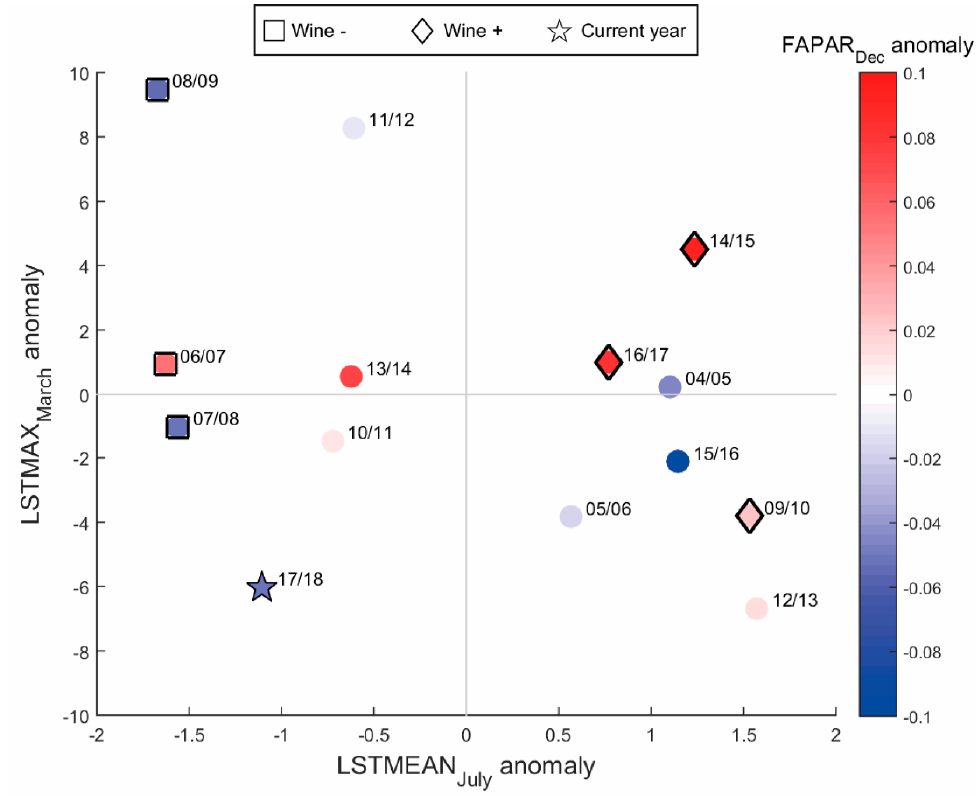
Figure 7. Anomalies of the retained predictors—December FAPAR; July LST MEAN and March LST MAX—throughout the DDR wine production years. Squared symbols represent the Wine - class (PDO wine production above the 3rd quartile) and diamond symbols represent the Wine + class (PDO wine production below the 1st quartile). Star symbol represents the conditions of the current year and circles the remaining wine production